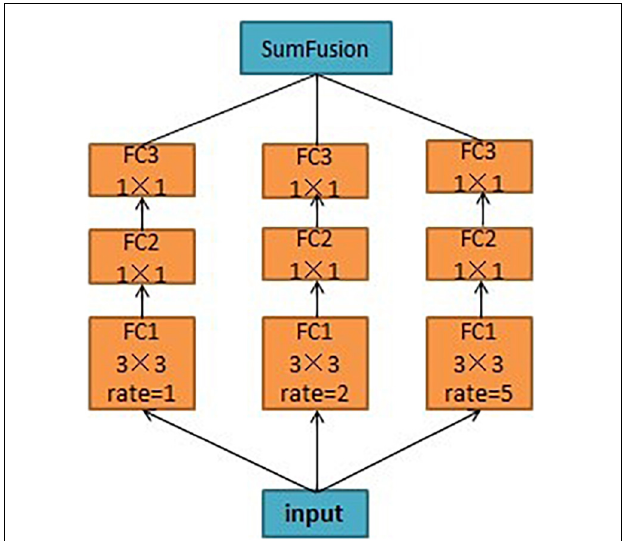
FIGURE 7 | Atrous spatial pyramid pooling (ASPP) structure.